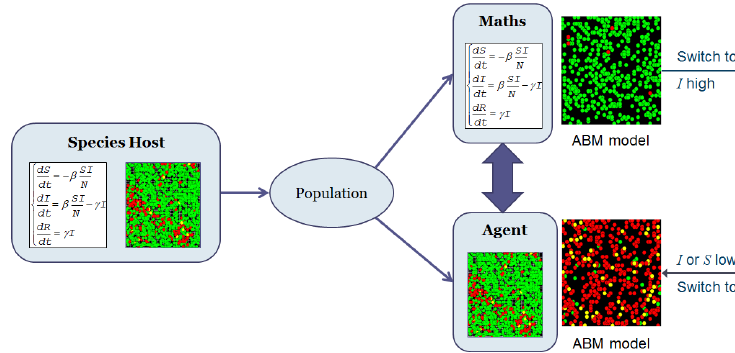
Figure 2. Representation the dynamic of "Switch"